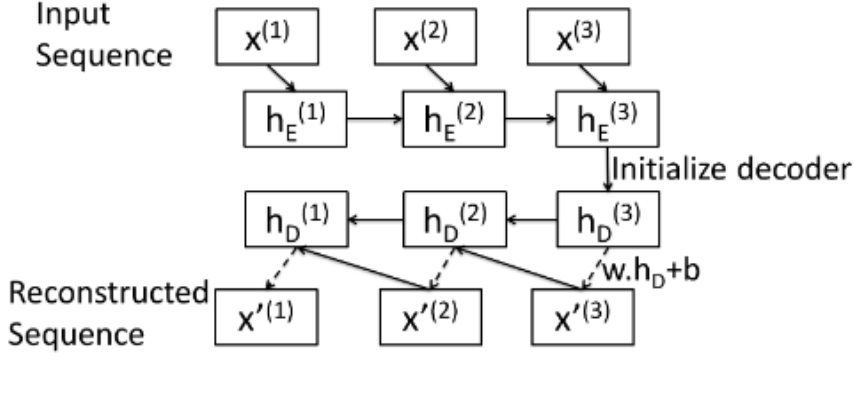
Figure 3. LSTM autoencoder by Malhotra et al. [37]. In this architecture, the encoder and the decoder are both LSTM networks. The last hidden state of the encoder is passed as the initial hidden state to the decoder. Then, at every instant t , the decoder takes as input the reconstruction of the previous instant x (cid:48) ( t − 1 ) obtained by linear transformation of the hidden state h t − 1 computed by the decoder